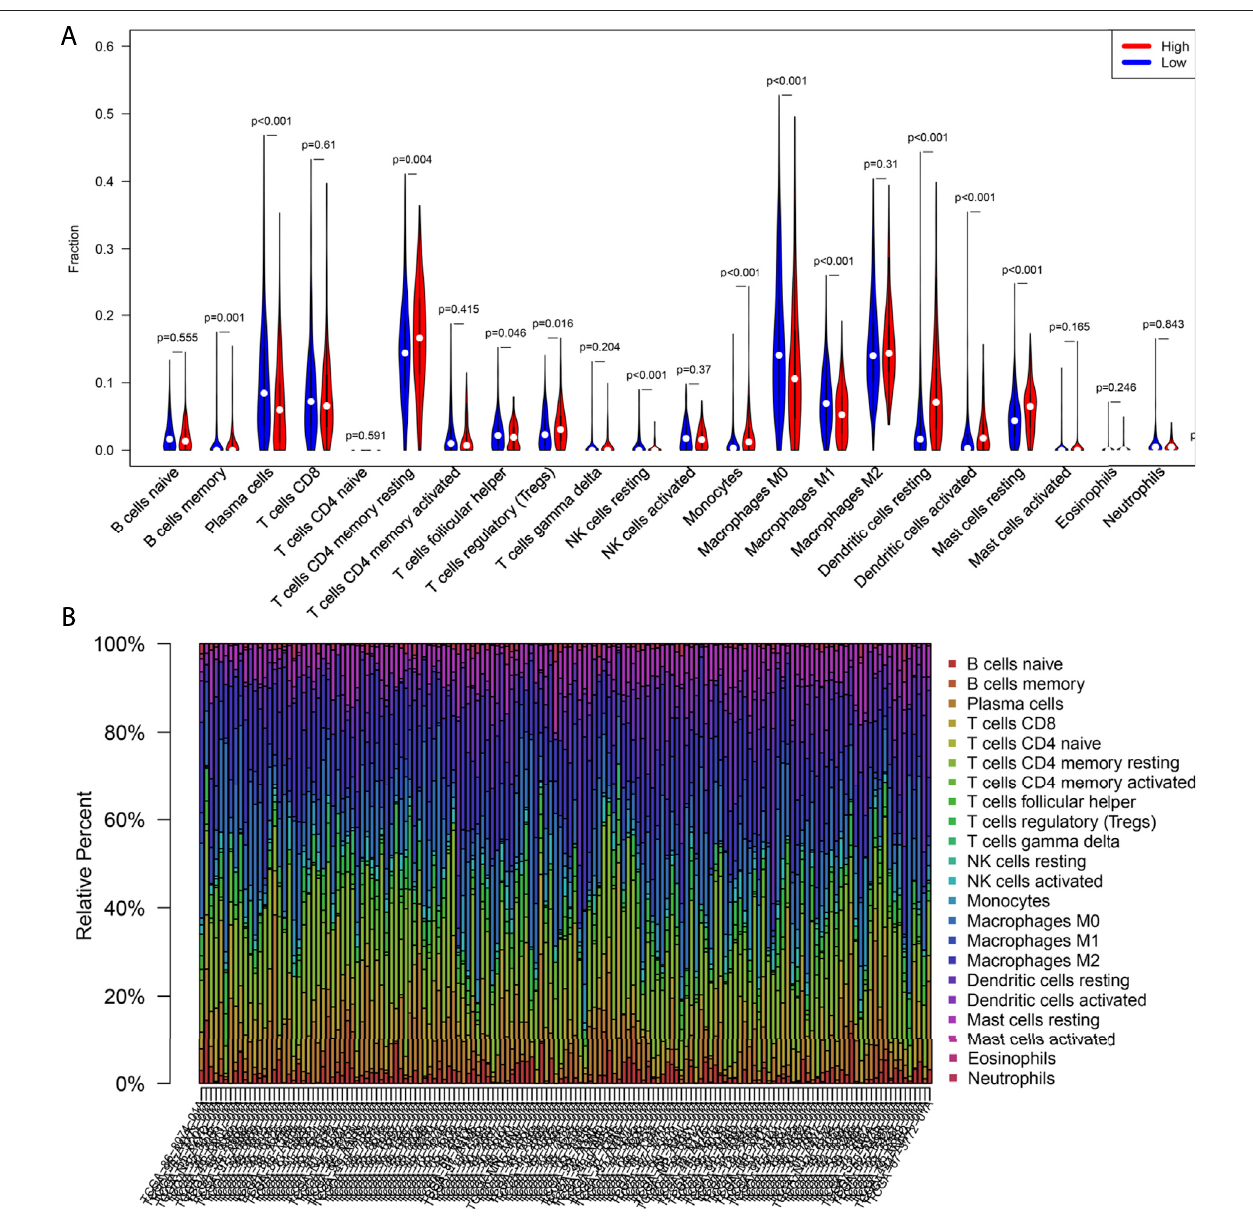
FIGURE 7 | Correlation between CCL17 expression and immune cell in fi ltration. (A) Violin plot of CCL17 high- and low-expression groups in LUAD patients. (B) Proportion of 22 immune cells in LUAD in the CCL17 high-expression group.